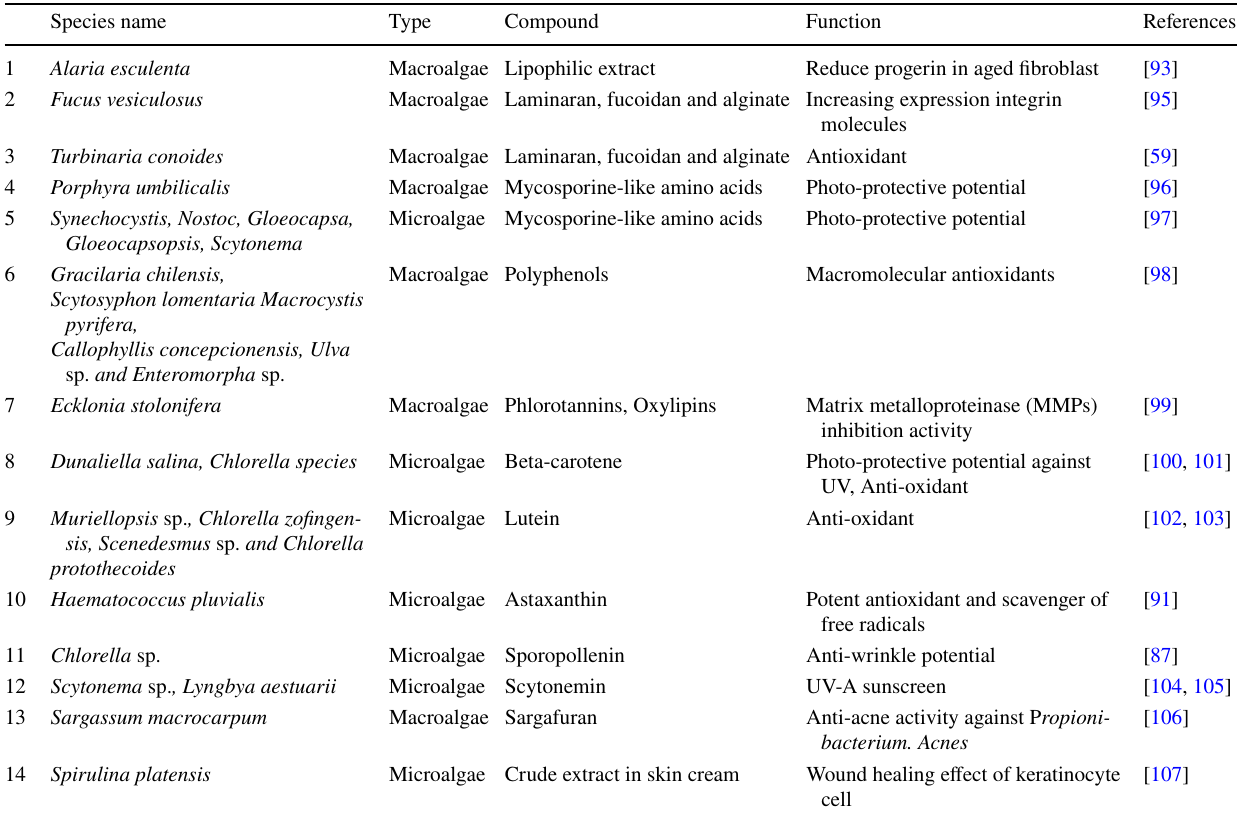
Table 3 Origin, function of potential biomolecules from